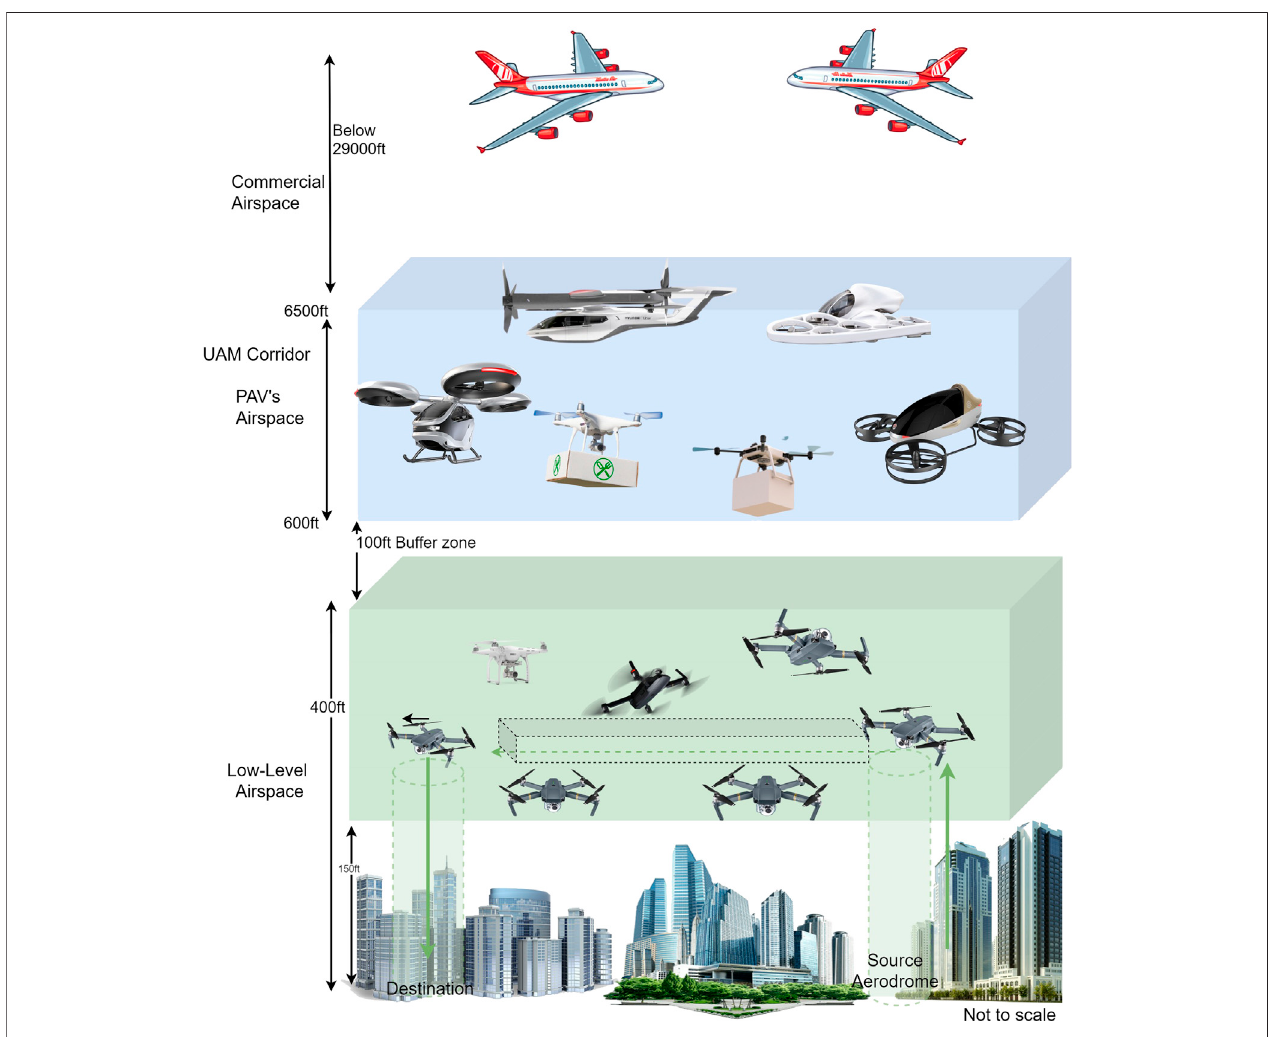
FIGURE 1 | General low-altitude airspace